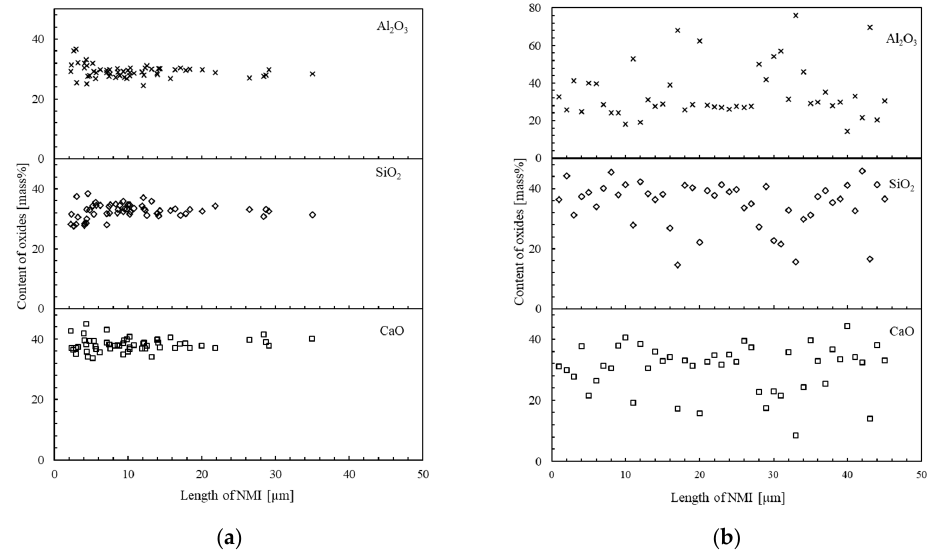
Figure 6. Relationship between the Al 2 O 3 , SiO 2 , and CaO contents and length of Type III ( a ) and Type IV ( b ) oxide inclusions in 316Ca steel.